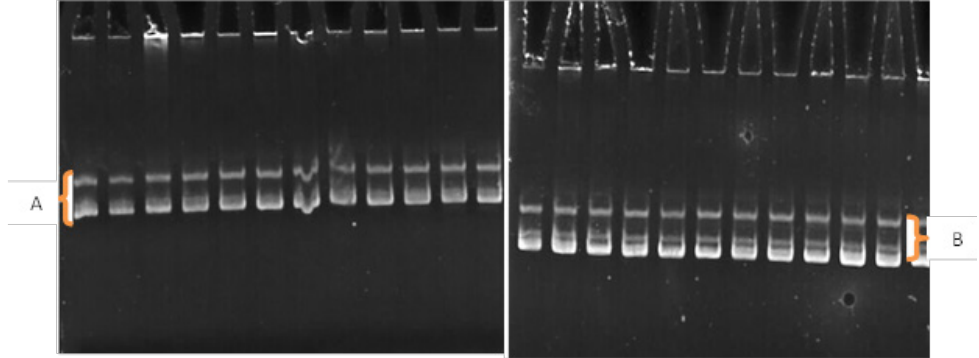
Fig. 3. The electrophoresis pattern of PCR-SSCP technique for MIR-146a gene, ( Pattern A:2 bands) and (Pattern B:3 bands)for both patients and